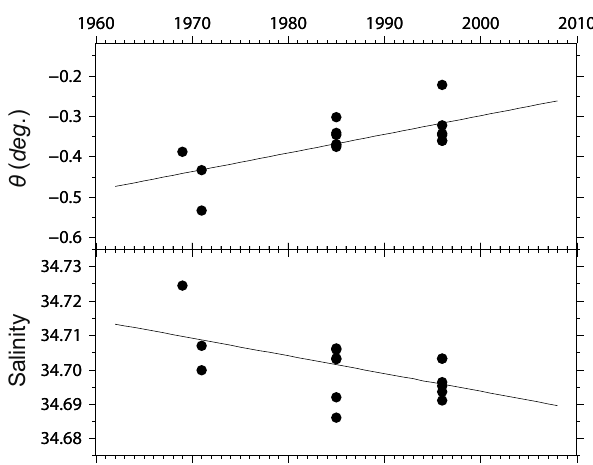
Fig. 10. Potential temperature (upper panel) and salinity (lower panel) averaged over the 100m-thick layer at the bottom vs. year with regression lines from region around 150 ◦ E. Profiles locate within box (a) in Fig. 6d are used here.